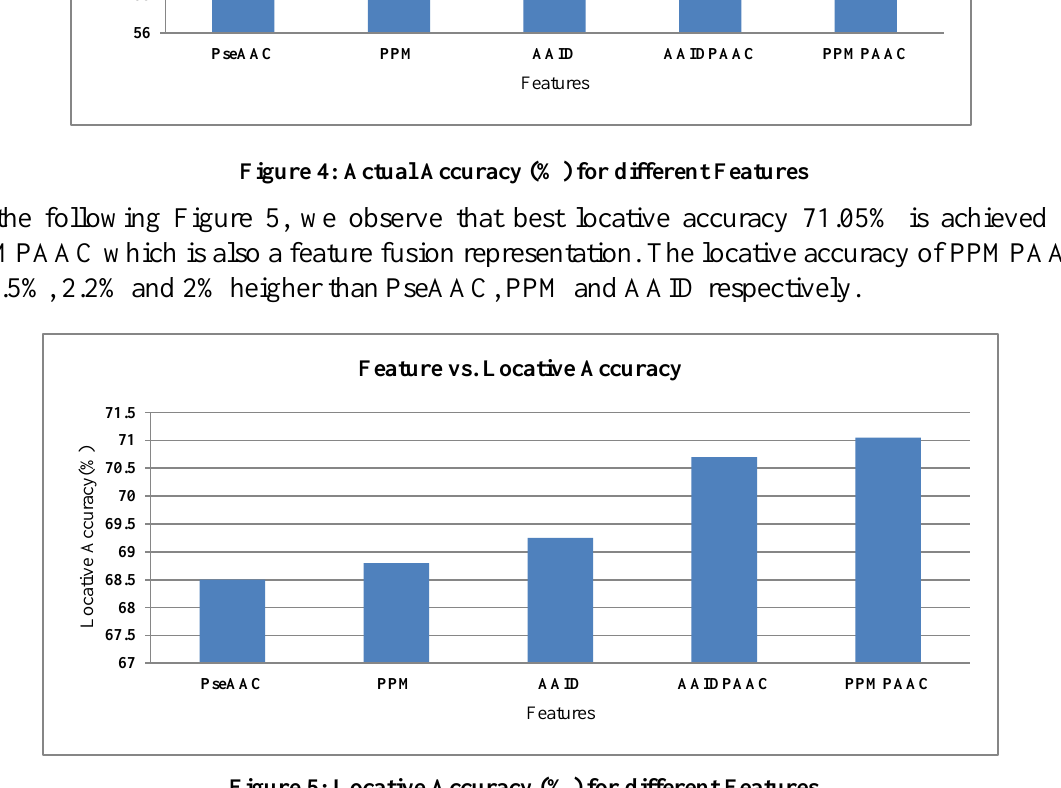
Figure 5: Locative Accuracy (%) for different